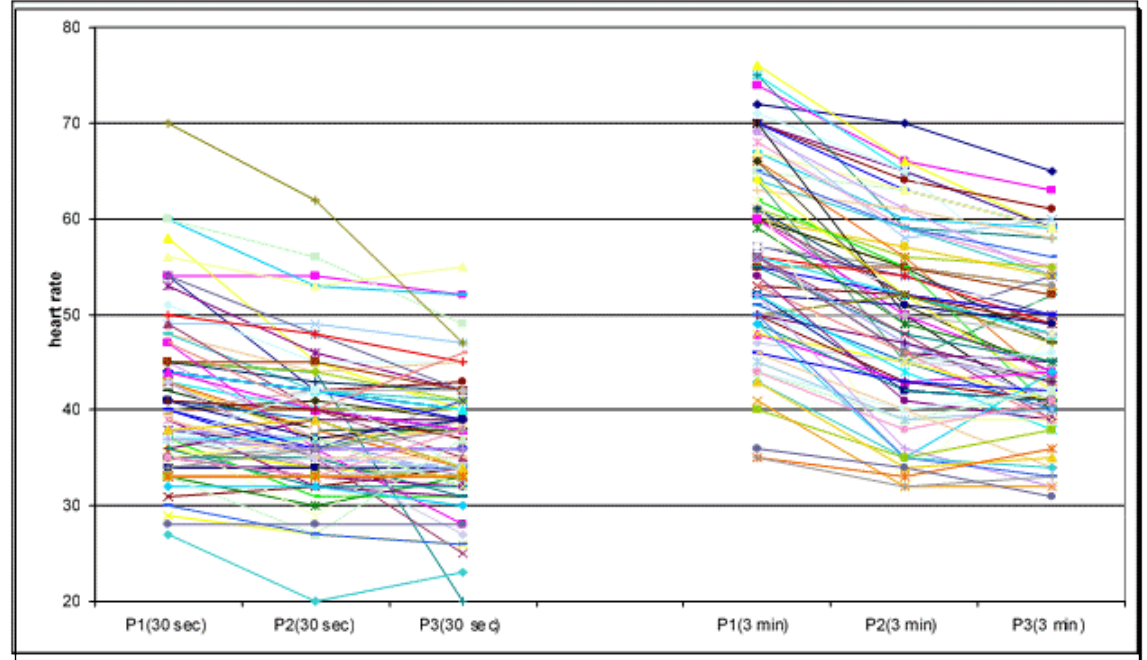
Fig.1. Results of heart beats rate (HBR) measurements with fulfillment of 3 minutes’ and 30 seconds’ variant of Harvard step-test.